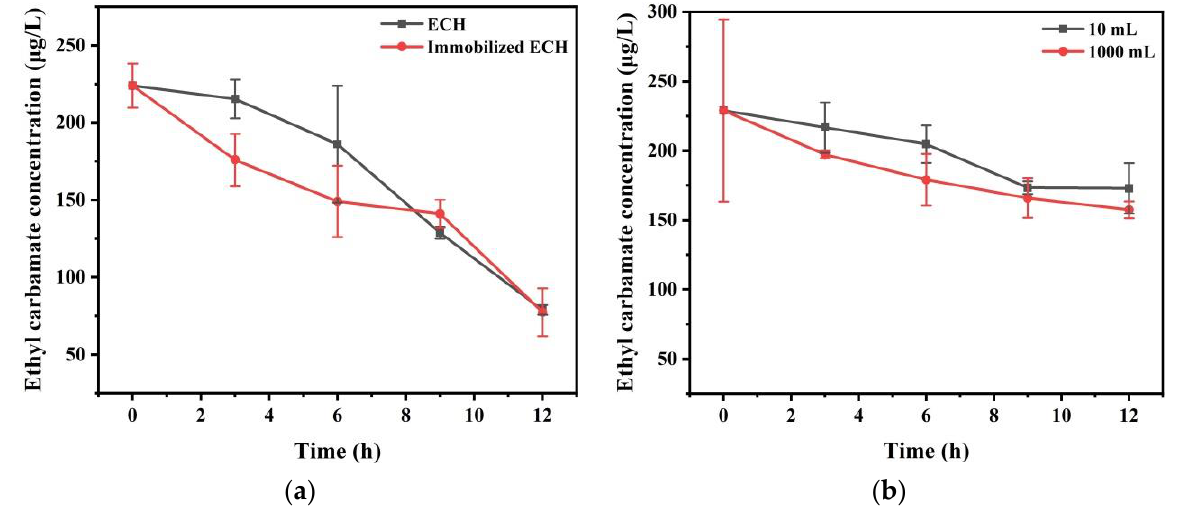
Figure 3. Regulatory effects of immobilized ECH on EC in simulation system and Chinese liquor. ( a ) ECH and immobilized ECH (4000 U/L) was added to the simulation system at 50 °C for 12 h; ( b ) immobilized ECH (4000 U/L) was added to different volume of the Chinese liquor (10 mL, 1000 mL) at 50 °C for 12 h.